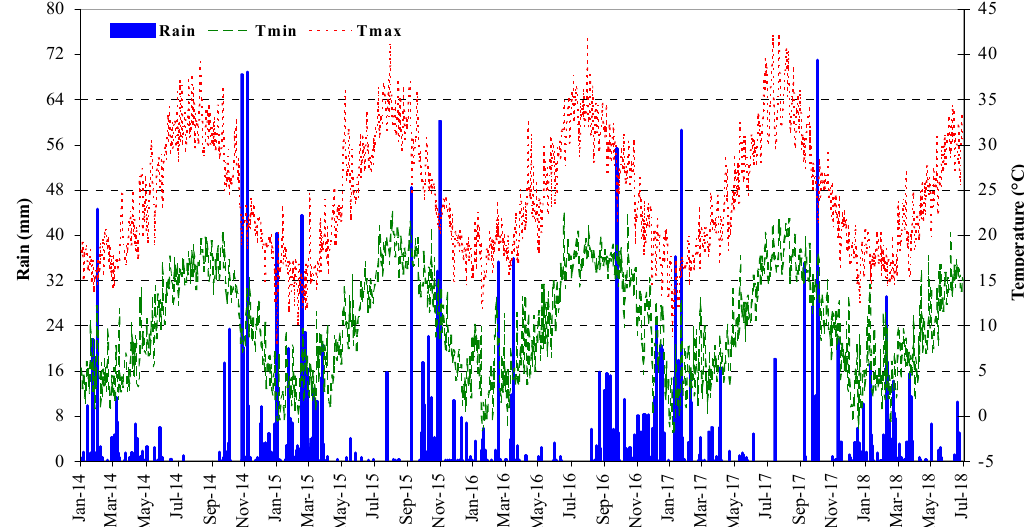
Figure 5. Rain precipitation (mm) and minimum and maximum air temperature (°C) values from January 2014 to June 2018 at the study site.